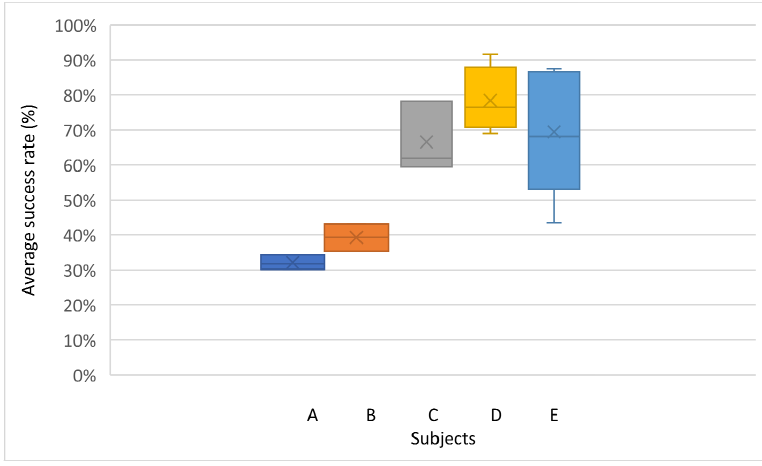
Figure 18. Distribution and average percentage of success of each subject. In Figure 19, the number of movements performed is displayed as a function of the time spent in completing the task.